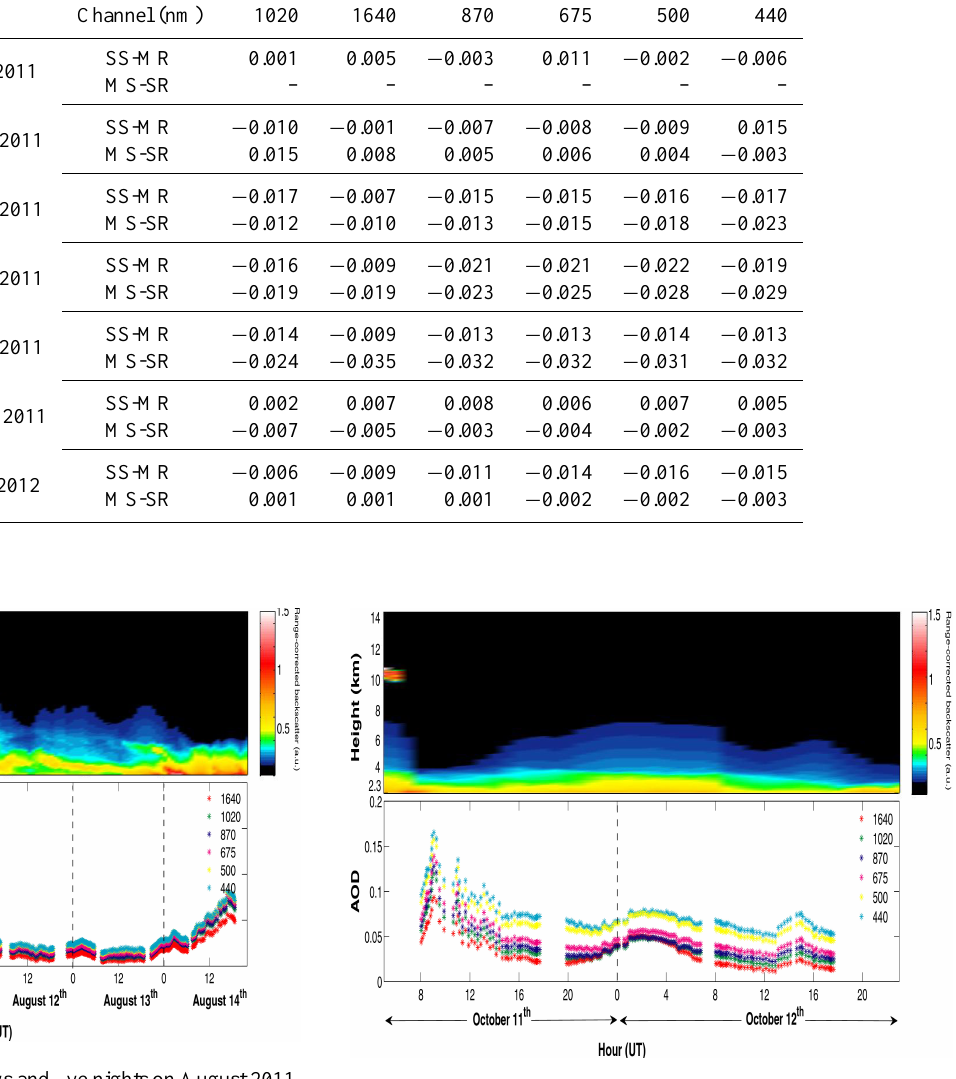
Table 4. τ a averaged differences between daytime AERONET and CE-1 data during sunset-moonrise (SS-MR, as the last 1-h of daytime AERONET data versus the first 1-h of nocturnal CE-1 data) and moonset-sunrise (MS-SR, as the first 1-h of daytime AERONET data versus the last 1-h of nocturnal CE-1 data).